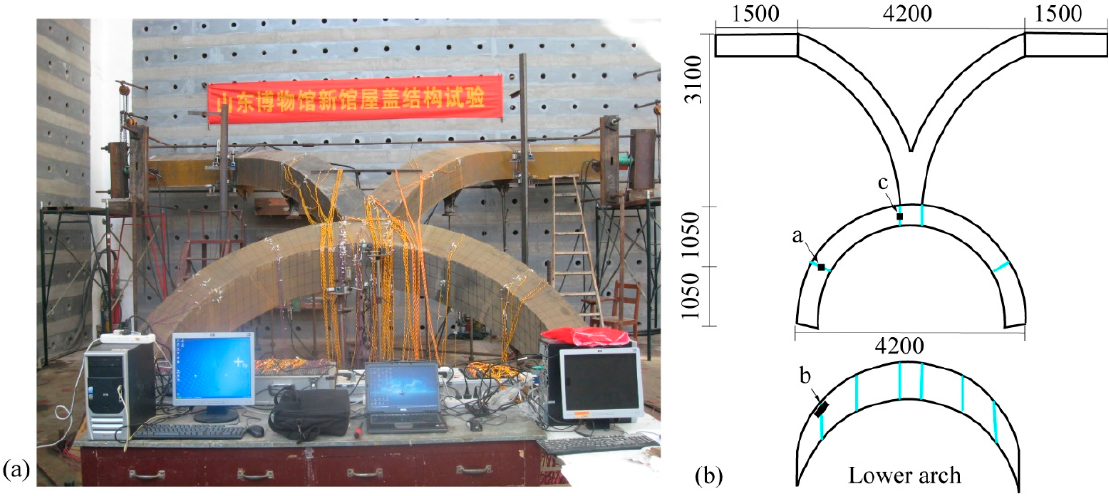
Figure 7. ( a ) The specimen and ( b ) its geometrical details (units in mm). Representative points at the a and b sections on the lower arch and c section have been selected for strain comparison, as shown in Figure 8a–d, respectively. The a , b , and c sections are marked in Figure 7b. Displacement plots of the juncture node in the horizontal (parallel